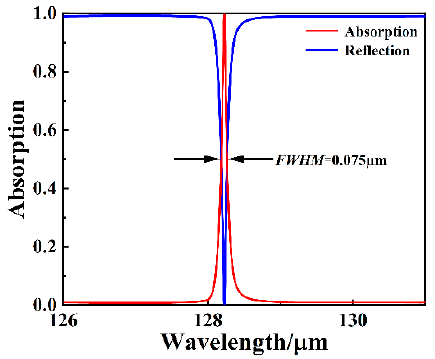
Figure 3. Simulated spectra of reflection ( R ) and absorption ( A ) of the presented structure.